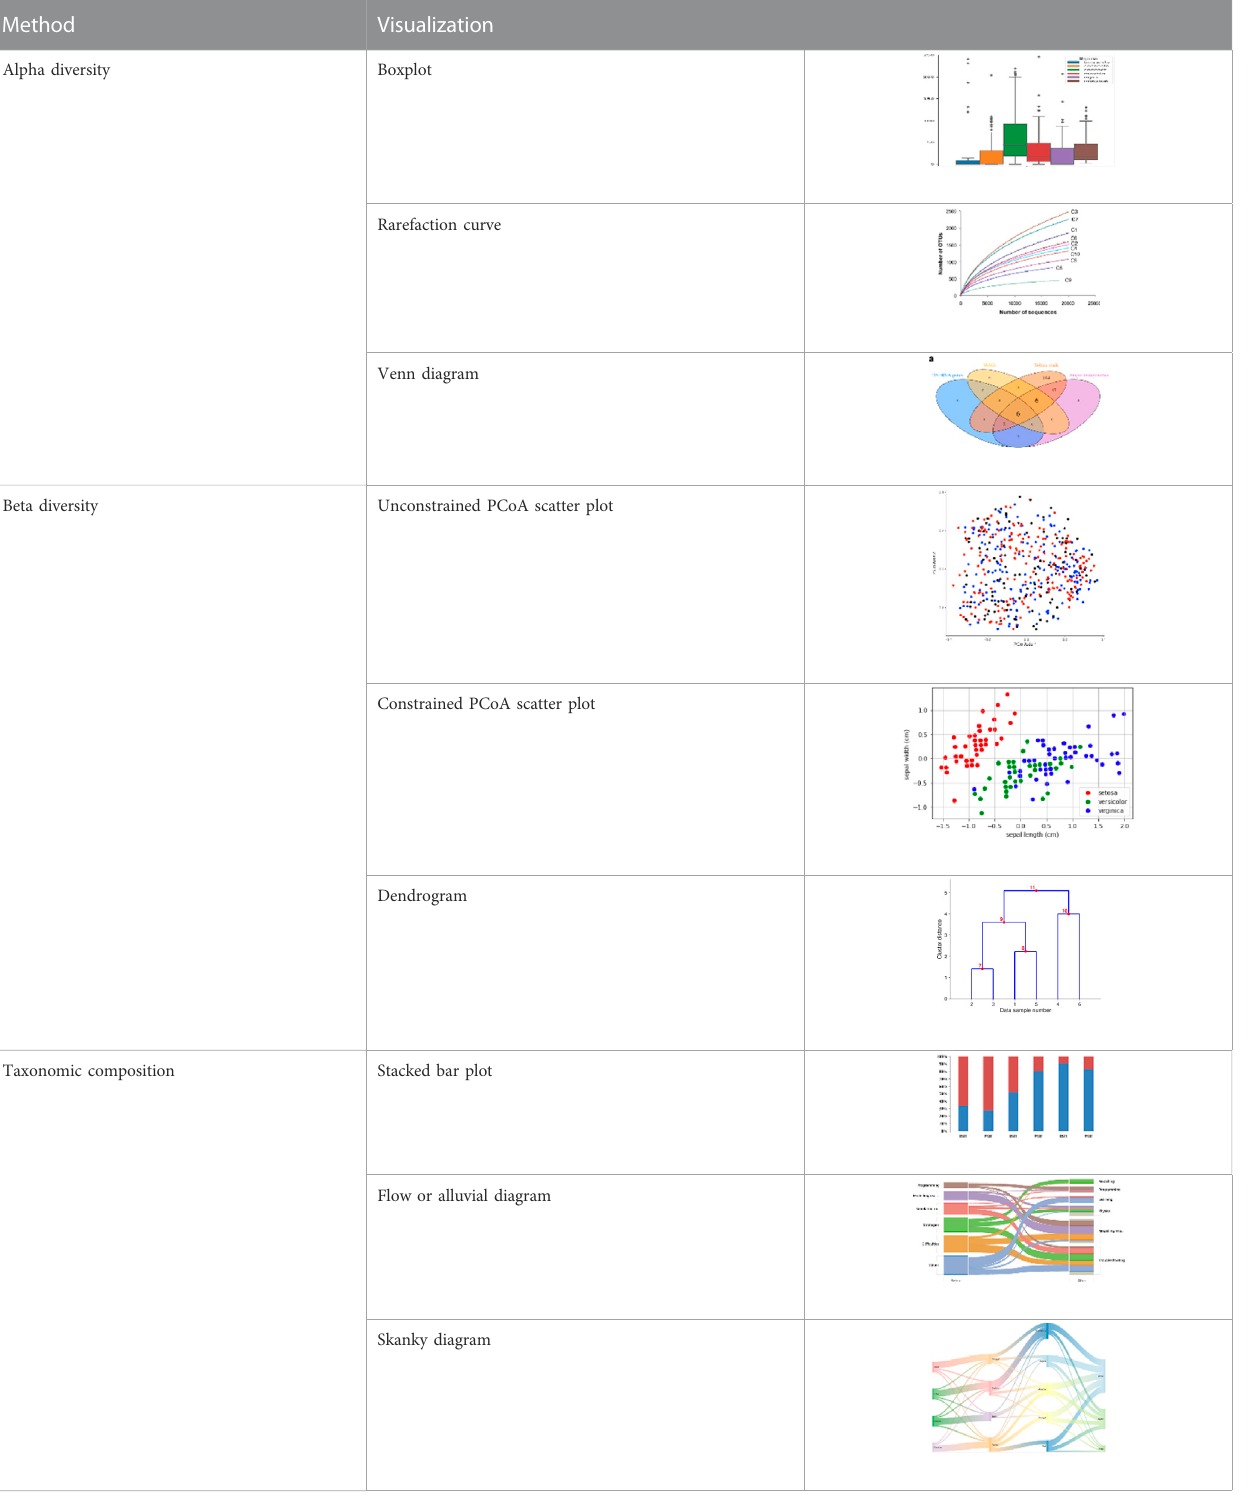
TABLE 2 The different analyses of the sequence data and its visualization